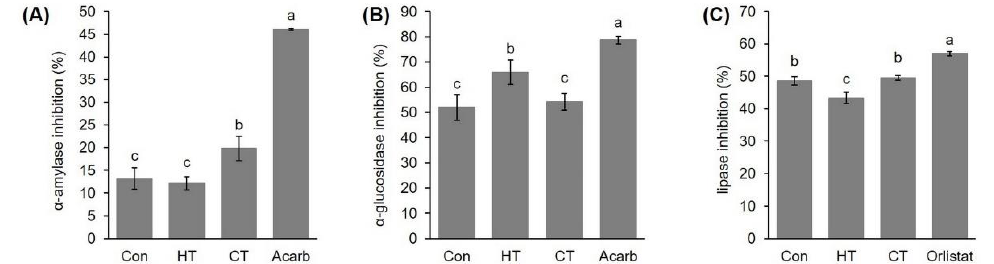
Figure 2. Effects of hot- and cold-water stress on the potential of extracts of young broccoli plants to inhibit the enzymes ( A ) α -amylase, ( B ) α -glucosidase and ( C ) lipase activity expressed in percent- age of inhibition (%). Values represent mean ± standard deviation of three biological replicates. Dif- ferent letters indicate a significant difference among the values (ANOVA, Duncan test, p ≤ 0.05). Con = plants watered with room temperature water, HT = plants watered with high temperature water, CT = plants watered with cold water, Acarb = acarbose. 2.7. Representation and Distribution of Decreased, Unchanged and Increased Variables in Young Broccoli Plants Due to Hot/Cold-Water Treatment Based on all the measured variables, we concluded that hot water changed more var- iables of young broccoli than cold-water treatment. To be precise, 72% of measured vari- ables were changed after hot-water-, and 24% after cold-water treatment (Supplementary Figure S1, Supplementary Table S2). Among the changed variables upon hot-water treat- ment, 62% of them increased and 38% decreased, while upon cold-water stress, 43% in- creased and 57% decreased. Regarding the identified individual compounds, the order of compounds in each group is the same; the most represented was L -ascorbic acid with 56% in the control group, 57% in the group treated with water of reduced temperature and 72% in the group treated with water at an elevated temperature (Supplementary Figure S2). The second most abun- dant was sinapic acid; however, unlike L -ascorbic acid, its concentration in the treated groups was lower than in the control group. Specifically, it was 31% in the control group, 30% in the group treated with cold water and only 16% in the group treated with hot water. The third most abundant compound was kaempferol, followed by ferulic acid, quercetin and, finally, p -coumaric acid.